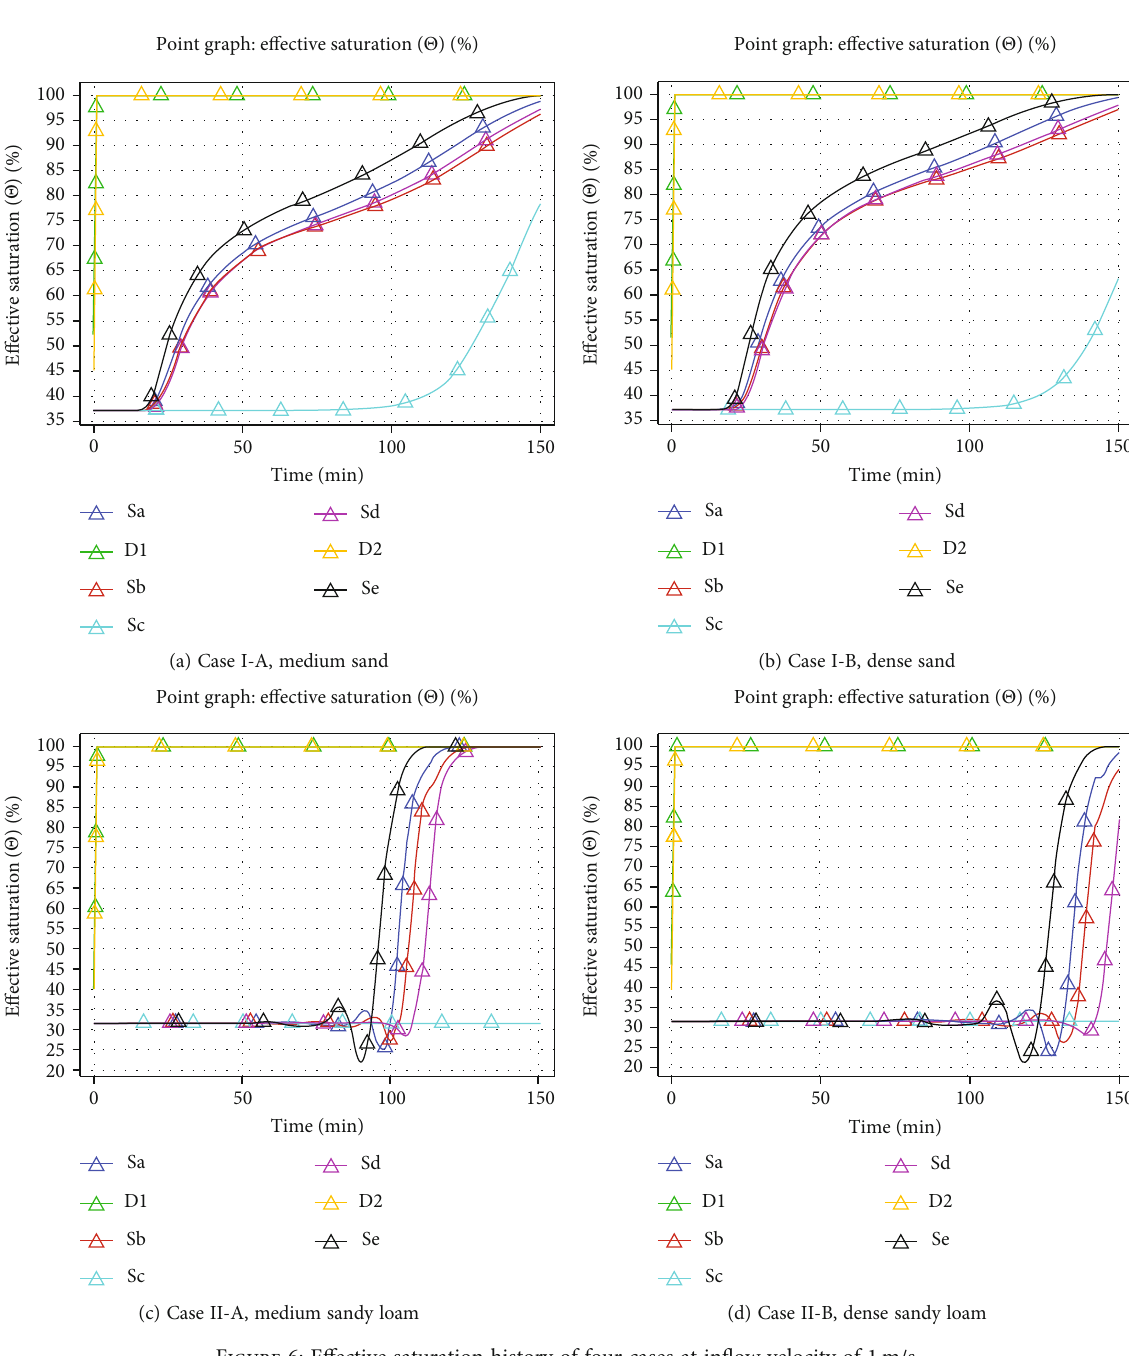
Figure 6: E ff ective saturation history of four cases at in fl ow velocity of 1